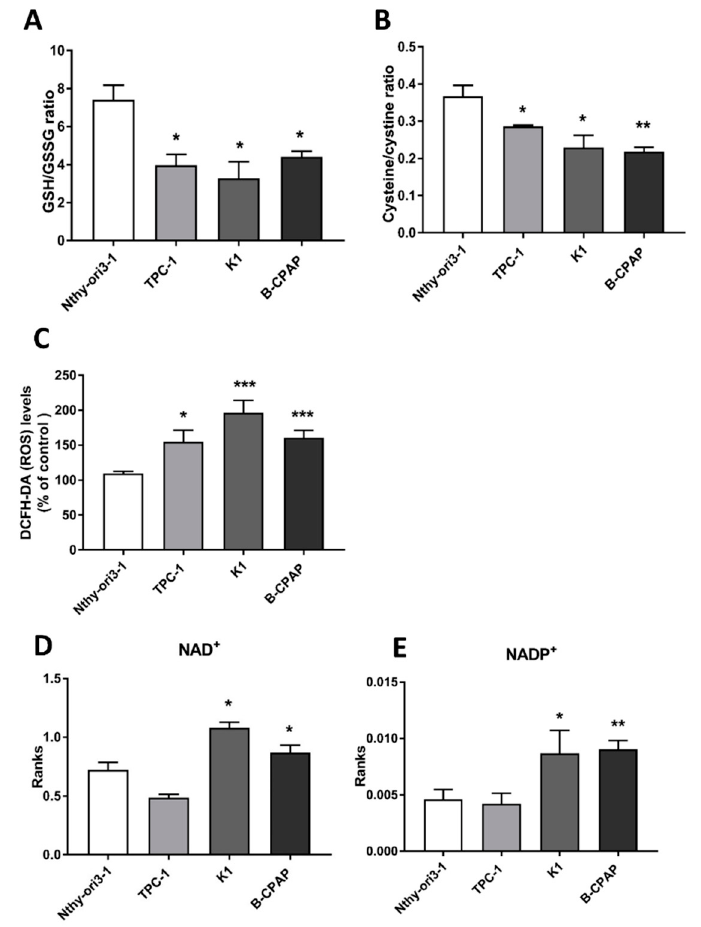
Figure 4. Redox control in human thyroid cell lines . ( A ) GSH/GSSG ratio in human thyroid cell lines. ( B ) Levels Cysteine/Cystine ratio in human thyroid cell lines. ( C ) Oxidant level in human thyroid cancer cell lines, expressed as % of control (human thyroid cell line, Nthy-ori3-1) ( D ) Intracellular NAD + levels. ( E ) Intracellular NADP + levels detected by UHPLC-MS/MS targeted analysis. Data are presented as means ± SD). All experiments were performed three times independently, each time in triplicate to confirm the results. Statistical analysis were performed by Student t -Test. Results were considered significant when * p < 0.05, ** p < 0.01, *** p < 0.001.